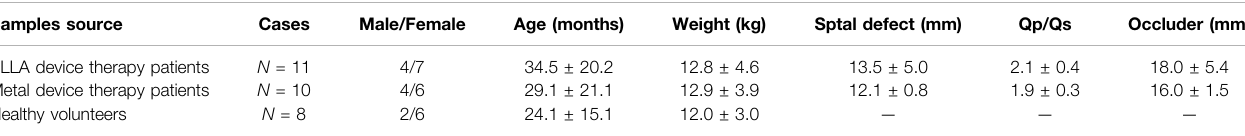
TABLE 1B | Basic characteristics of the patient samples of atrial septal defects used for qRT-PCR. Samples